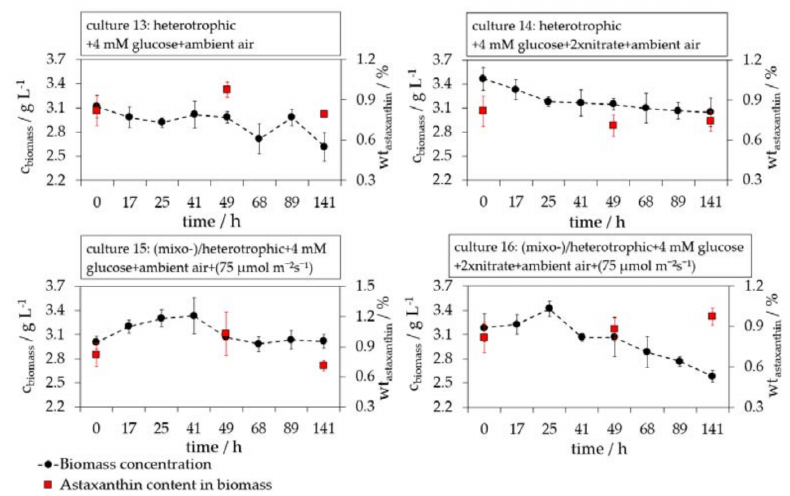
Figure 12. Time course of the biomass concentration and the astaxanthin content in the algal biomass of heterotrophic culture 13 (heterotrophic + 4 mM glucose + ambient air) and culture 14 (heterotrophic + 4 mM glucose + 2xnitrate + ambient air), and culture 15 (mixo-/heterotrophic + 4 mM glucose + ambient air + (75 µ mol m − 2 s − 1 )) and culture 16 (mixo-/heterotrophic + 4 mM glucose + 2xnitrate + ambient air + (75 µ mol m − 2 s − 1 )). Biomass concentration: error bars show ± SD, n = 3. Astaxanthin content: error bars show ± SD, n = 3 at t = 0 h, t = 49 h and t = 141 h and ± SD, n = 2 at t = 17 h, t = 25 h, t = 41 h, t = 68 h and t = 89 h of one biological sample; asterisks indicate significant differences ( t -test) of measured value vs. control (t = 0 h) at p <